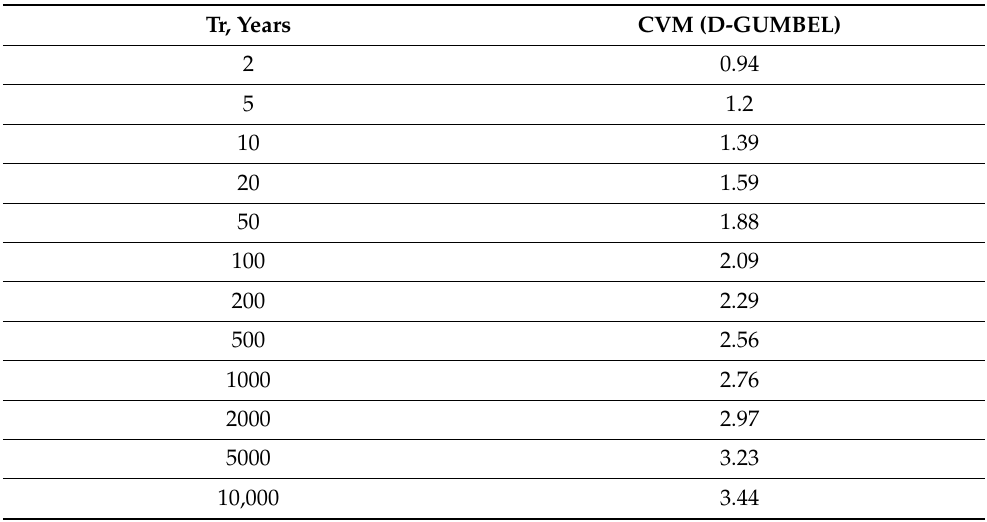
Figure 4. Coefficients map of variation for historical annual maximum daily rainfall in Mexico Valley. “Adapted from Ref. [21], 2022, SACMEX”. Table 1. Dimensionless regional factors for estimating annual maximum daily rainfall for different return periods Tr in years for Mexico Valley River Basin. “Information consulted from Ref. [21], 2022, SACMEX” Source: